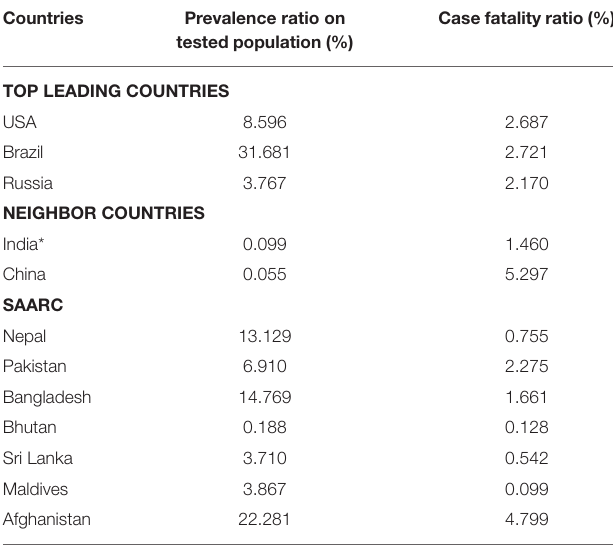
TABLE 1 | Prevalence and case fatality ratio (CFR) of COVID-19 of top leading countries, neighbor countries of Nepal, and SAARC as of Jan 28, 2021. Countries Prevalence ratio on tested population